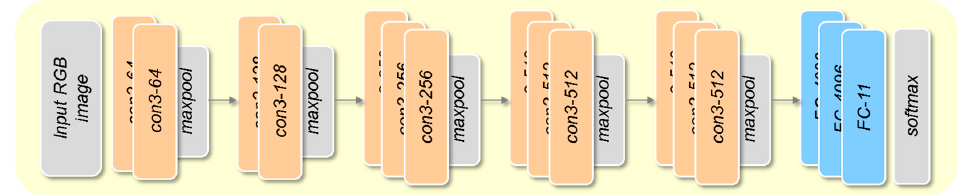
Figure 5. ConvNet configurations of VGG-16.